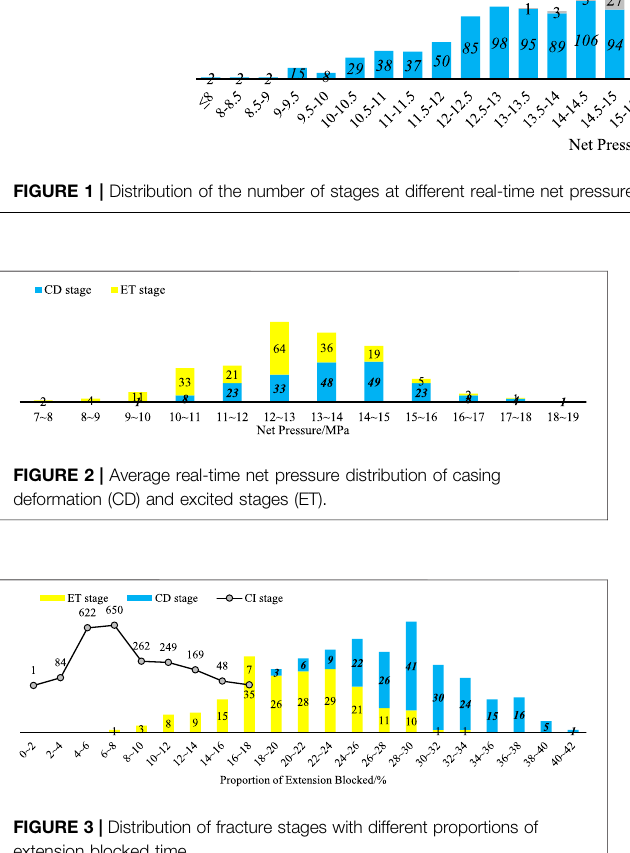
Frontiers in Energy Research |